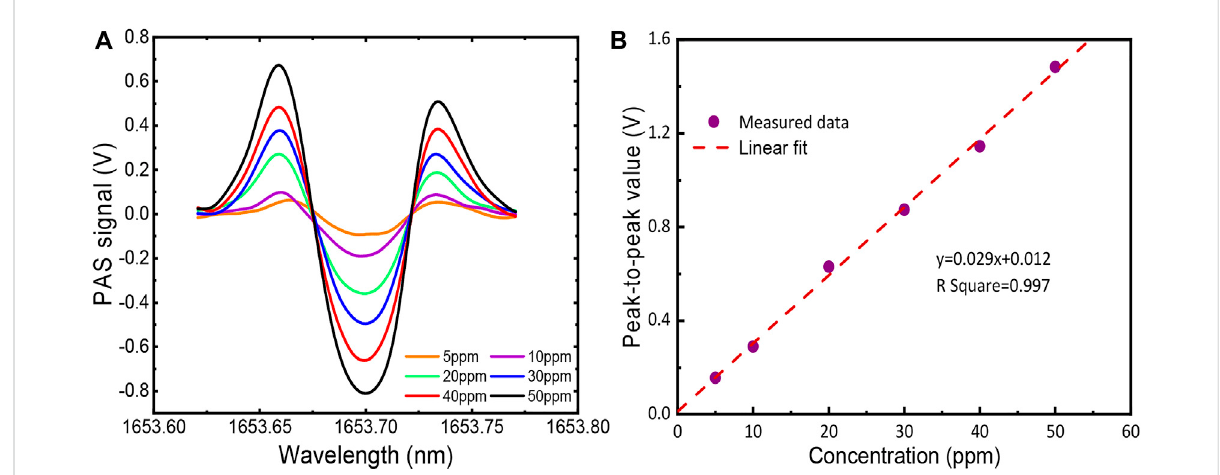
minimum detection limit appears at 84 s and approaches 116 ppb. The sensor was validated by real-time and in situ measurements of atmospheric CH 4 for 2 days. The test was